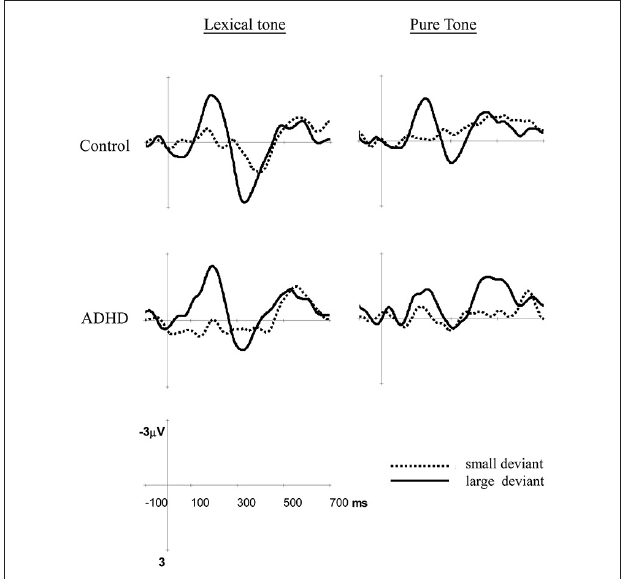
FIGURE 1 | Differential event-related potentials (ERPs) for lexical tones and pure tones in these two groups at Fz. Small deviant: T2/T3 and 1015/1000 Hz; large deviant: T1/T3 and 1090/1000